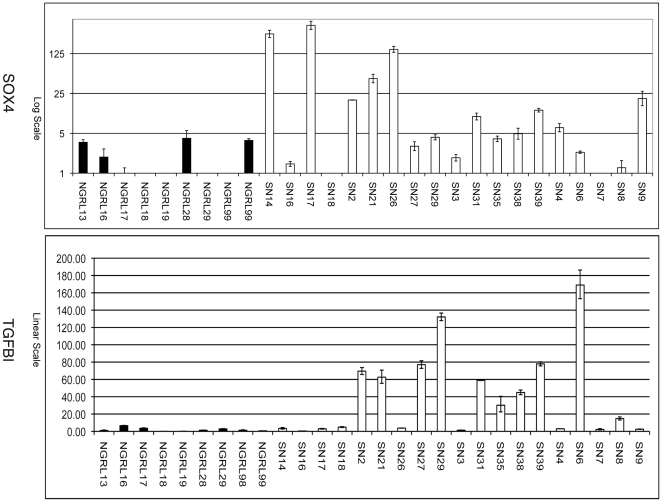
Bar charts showing the quantitative RT-PCR results of SOX4 and TGFBI (GENE ID:7045) on a panel of 19 individual brain tumor samples (SN series) and 9 individual normal brain tissue samples (NGRL series).Black bars, NGRL series (normal) samples; white, SN series (GBM) samples. Y-axis indicates relative expression levels and X-axis indicates individual samples. Three replicate PCR were performed and the standard errors of the mean were indicated by error bars. Both TGFBI (GENE ID:7045) and SOX4 were differentially expressed with increased expression in GBM tissues compared to normal brain (P<0.01 for both TGFBI (GENE ID:7045) and SOX4, T-test, two-tailed distribution, unequal variance). Please note that the Y-axis for SOX4 is in log scale in order to show the full extend of SOX4 expression in the samples.